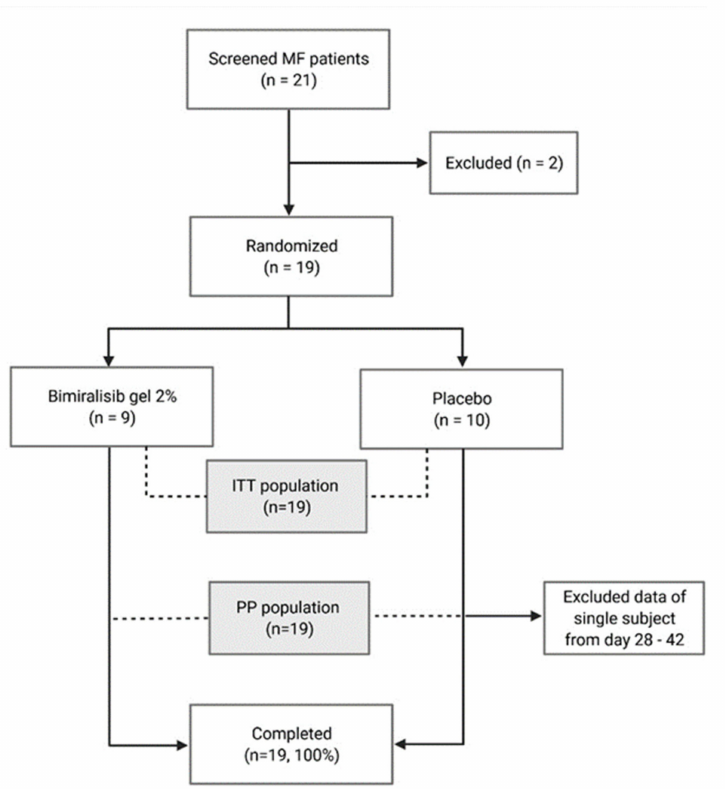
Figure 2. Study flow chart of part B with MF patients. ITT = intention to treat; PP = per protocol. Two patients were excluded for not meeting the inclusion criteria. Data of a single patient between days 28 and 42 were excluded due to a pharmacy dispensing